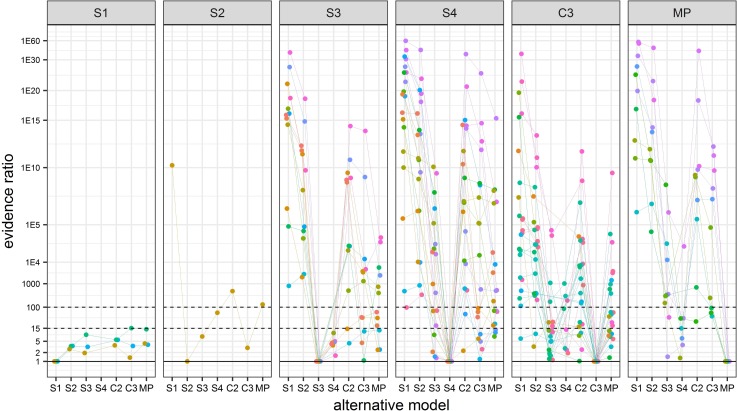
Plot of evidence ratio (ER) vs alternatives to the best model for each of the 68 animals.The ER value for the best model is 1 and values greater than 1 are the fold increase in likelihood in favor of the best model over the alternative model. Each panel gives the plot for all animals with the best model given at the top of the panel. Values from a single animal have the same color and are connected with lines.